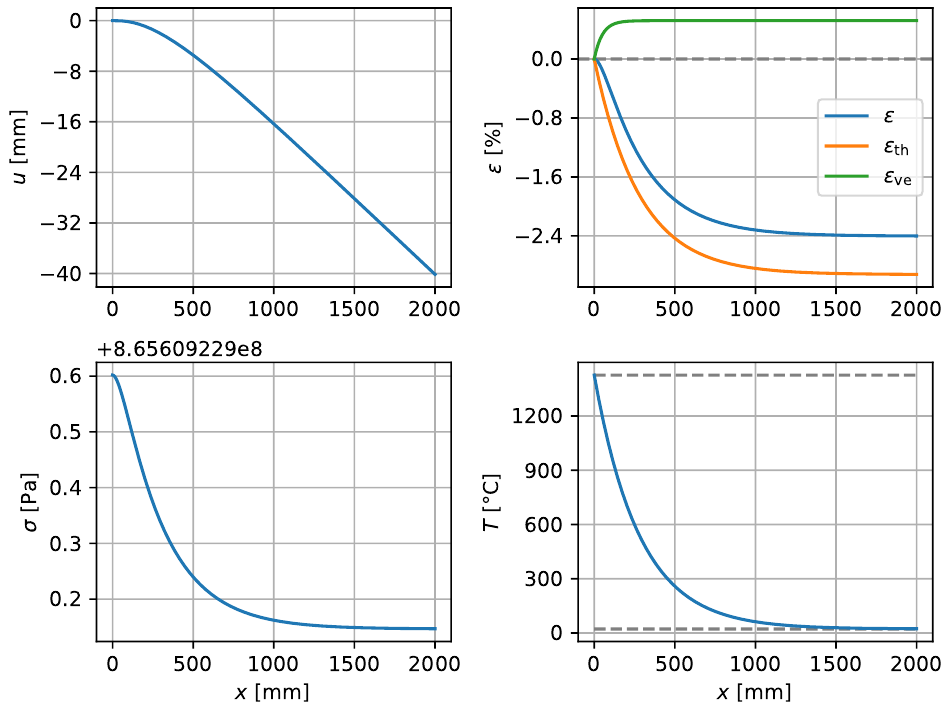
Figure 6. Artificial high-viscosity example, t ret = 1s. L = 2000mm, v = 50mm/s.